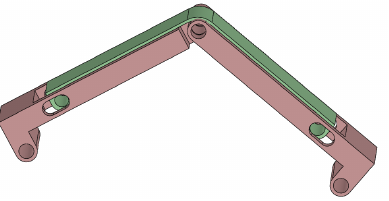
Figure 5. V structure for the elastic lamina support in the case of characterization of sensors in applications with fixed radius of curvature.